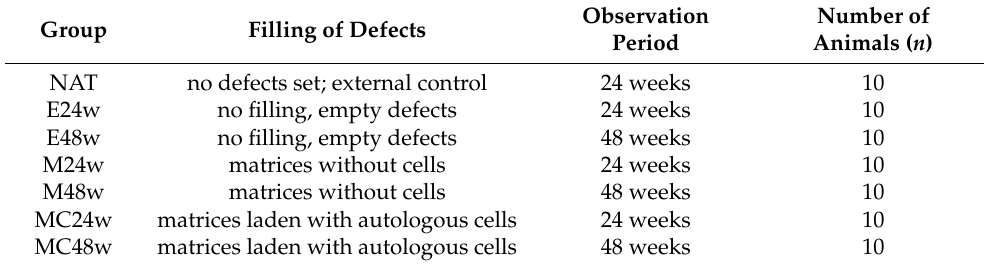
Table 1. The labeling of the groups and the different treatments of the defects. Each group consisted of 10 animals. The NAT group served as the external natural control because the stifle joints of the animals were not operated. The Col I matrices that the animals of the MC24w and the MC48 groups received were laden with autologous cells isolated from the removed cartilage tissue of the defects. Observation Number of Group Filling of Defects Period Animals ( n ) NAT no defects set; external control 24 weeks 10 E24w no filling, empty defects 24 weeks 10 E48w no filling, empty defects 48 weeks 10 M24w matrices without cells 24 weeks 10 M48w matrices without cells 48 weeks 10 MC24w matrices laden with autologous cells 24 weeks 10 MC48w matrices laden with autologous cells 48 weeks